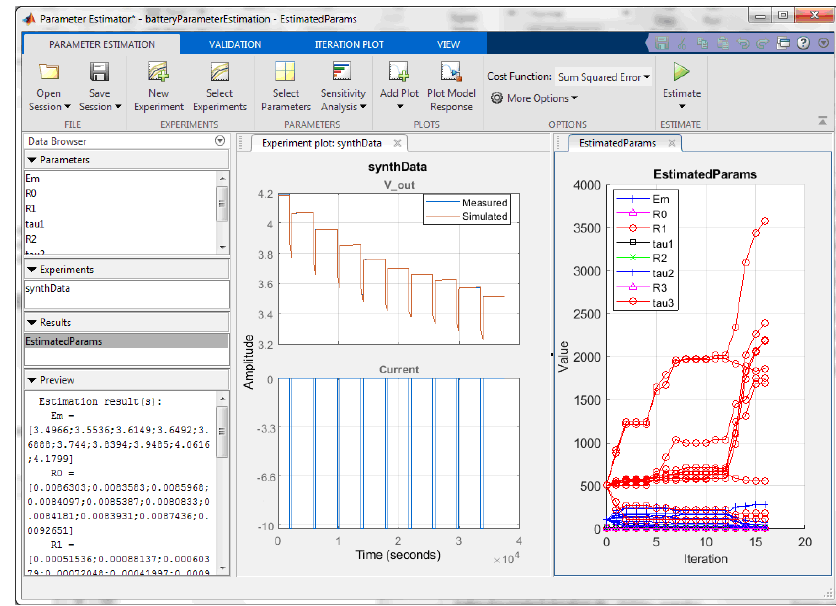
Figure 13. Results of battery parameter estimation.